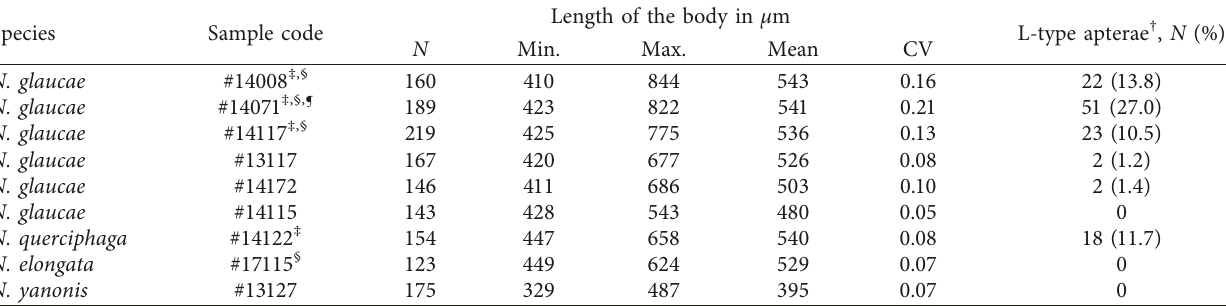
Table 3: Body lengths of Neothoracaphis apterous